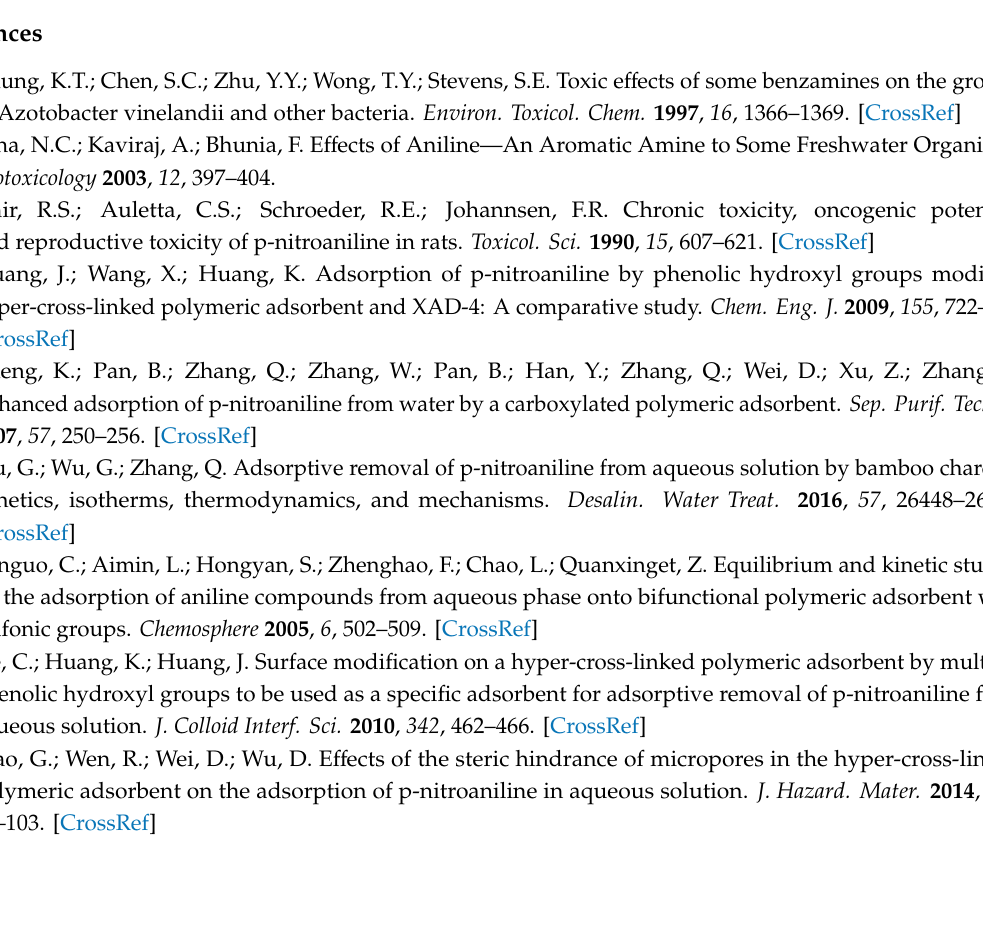
Figure S1: UV–Vis spectrum of p-NA in water (5 µ M) before porphyrin-treated mat dipping. Figure S2: UV–Vis spectrum of p-NA in water (5 µ M) before (black line) and after dipping (1 h) with porphyrin-treated mats H 2 TPP / PES (green line) or with ZnTPP / PES (red line). Figure S3: Absorption and emission spectra ( λ ex = 422 nm) of electrospun H 2 TPP / PES and ZnTPP / PES dissolved in toluene:DMF. Figure S4: UV spectra of 1.5 µ M ZnTPP toluene:DMF solution in absence and presence of